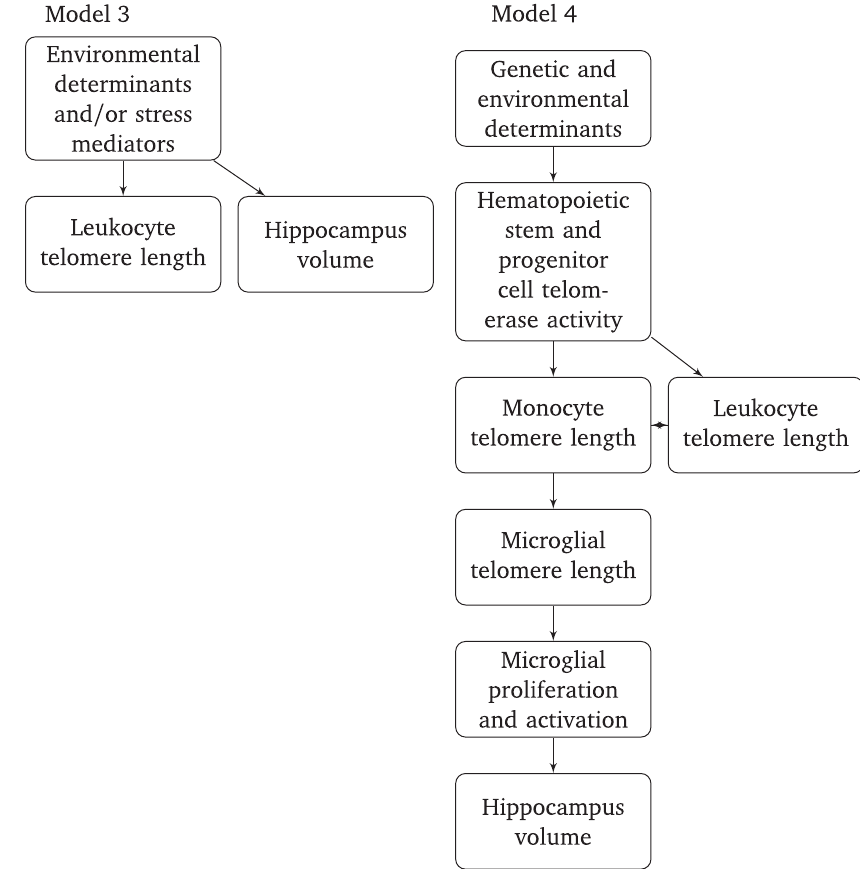
Figure 5. Two models proposed here for relationships between telomere length and hippocampus